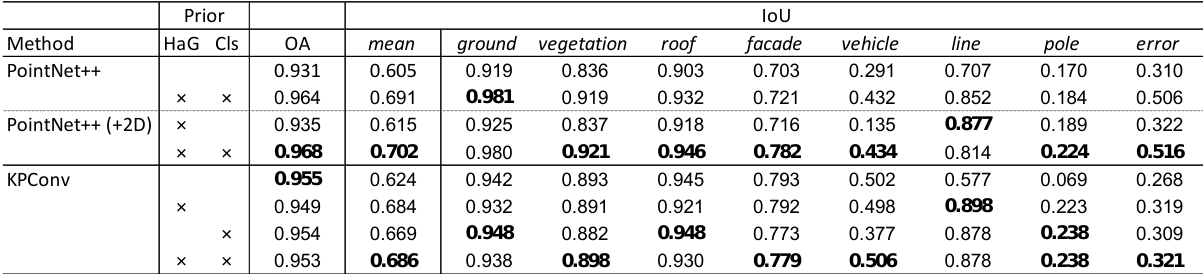
Table 1 . Overall accuracy (OA), mean and class-specific intersection over union (IoU) for the two reported Deep Learning networks of this study without and with height above ground (HaG) and input classes (Cls) as priors. Best scores are highlighted per network.